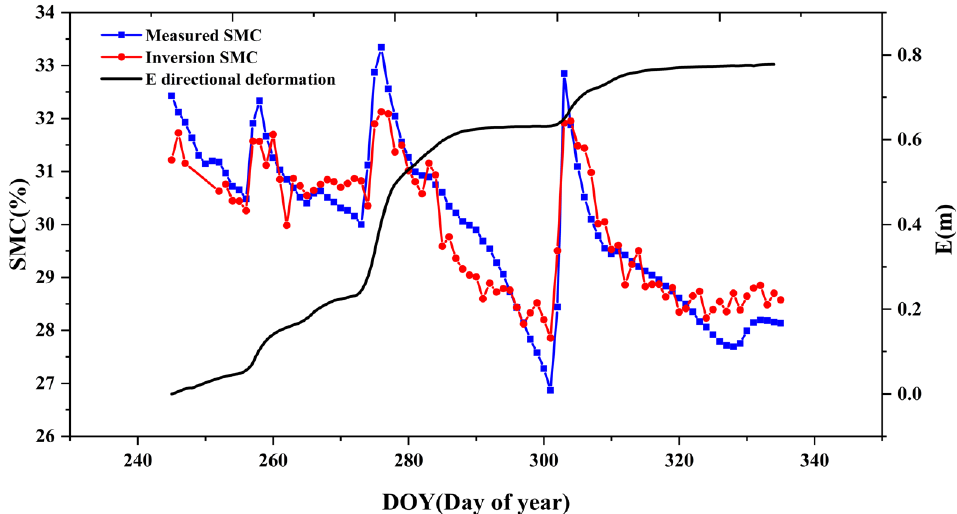
Figure 17. Relationship between soil moisture and deformation.